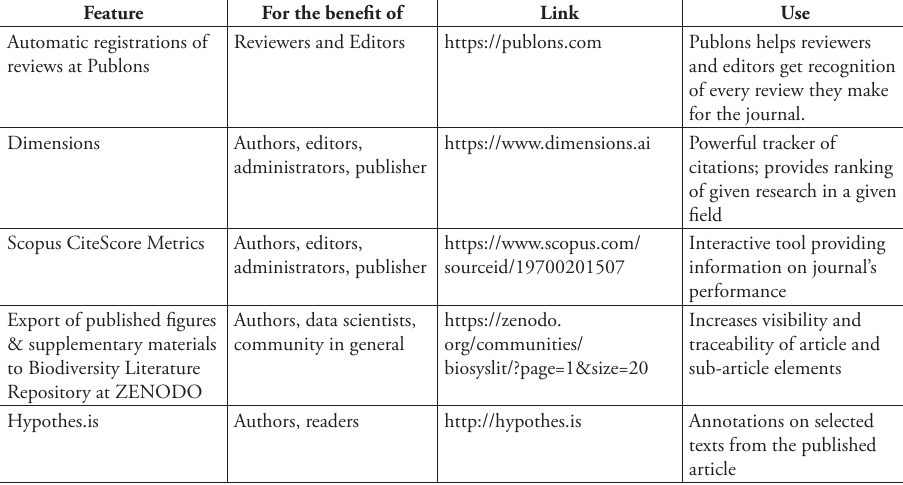
Table 3. New technological solutions implemented in the